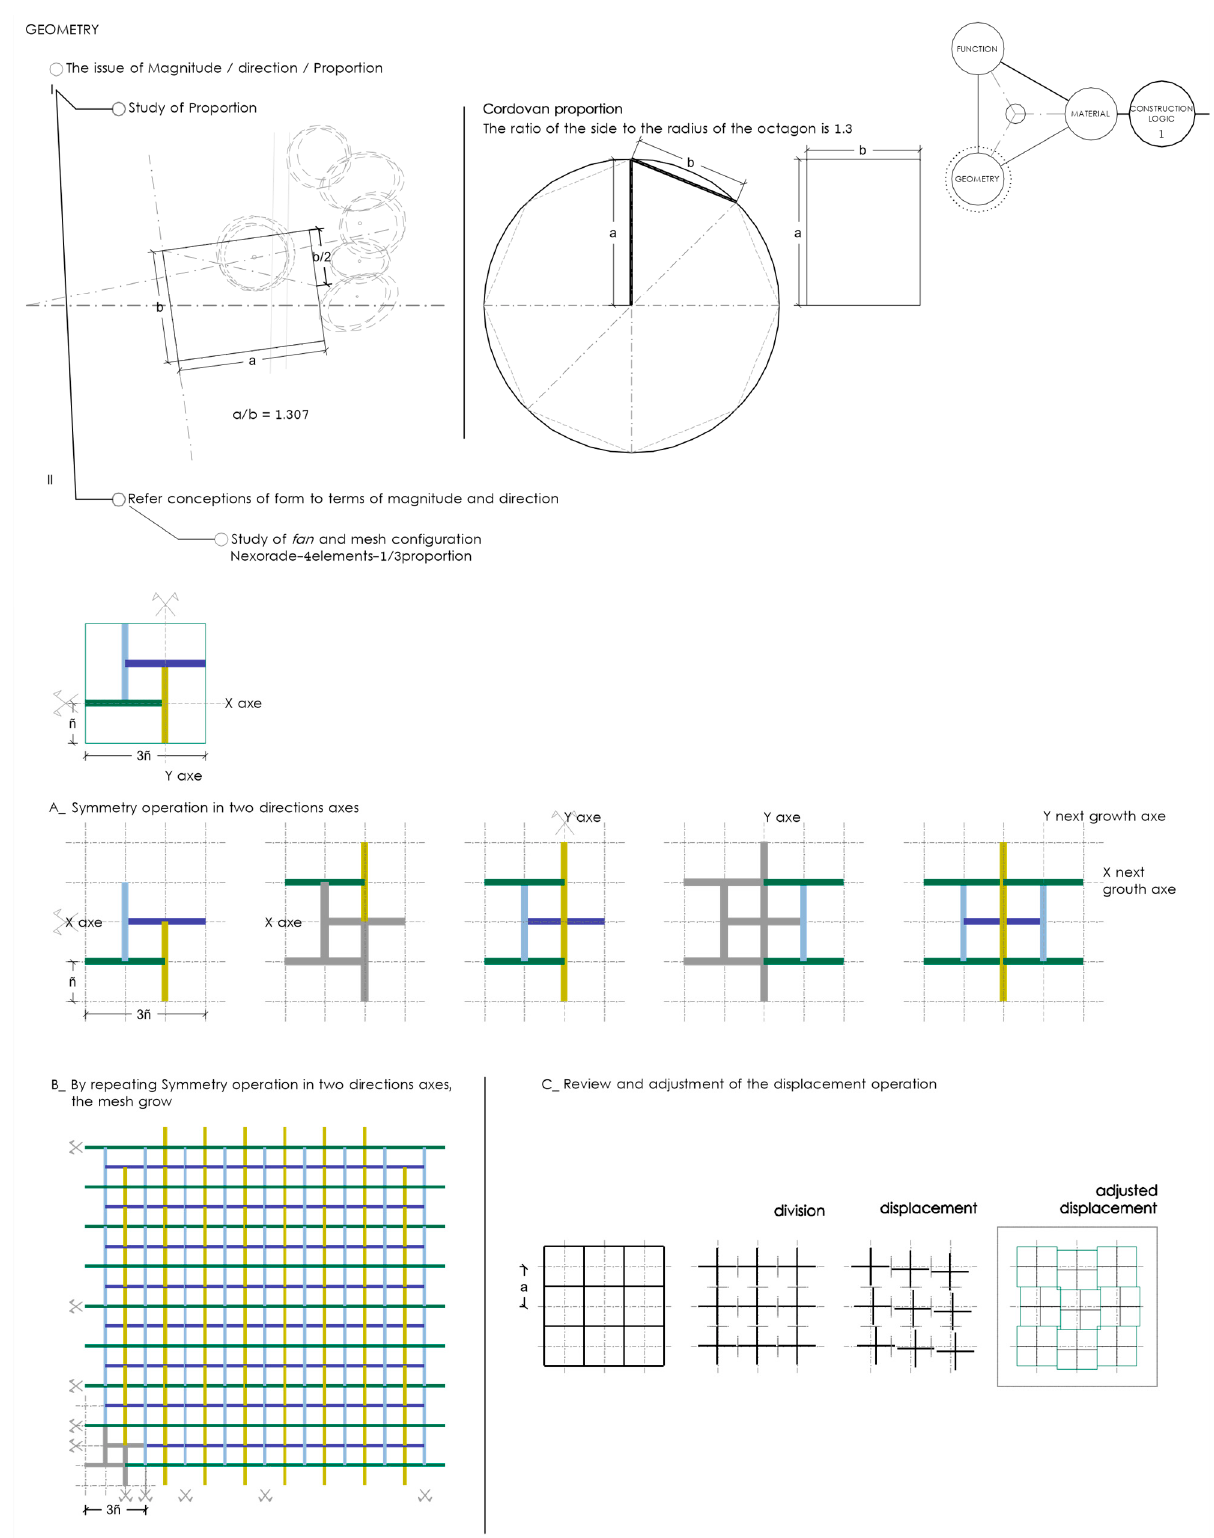
Figure 12. Construction logic matrix 1.